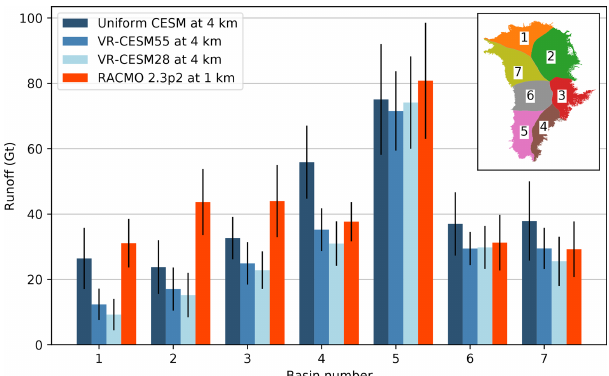
Figure 8. Mean basin-integrated runoff over the period 1980–1999. Error bars represent 1 standard deviation. CESM data have been manually downscaled down from their native resolution to 4km us- ing vertical SMB profiles generated by the elevation classes. For ref- erence, RACMO2 downscaled runoff at 1km resolution is shown. The extent of all basins combined equals the common ice mask in Table 2. Due to the manual interpolation, however, the total runoff for CESM does not match the value reported in Table